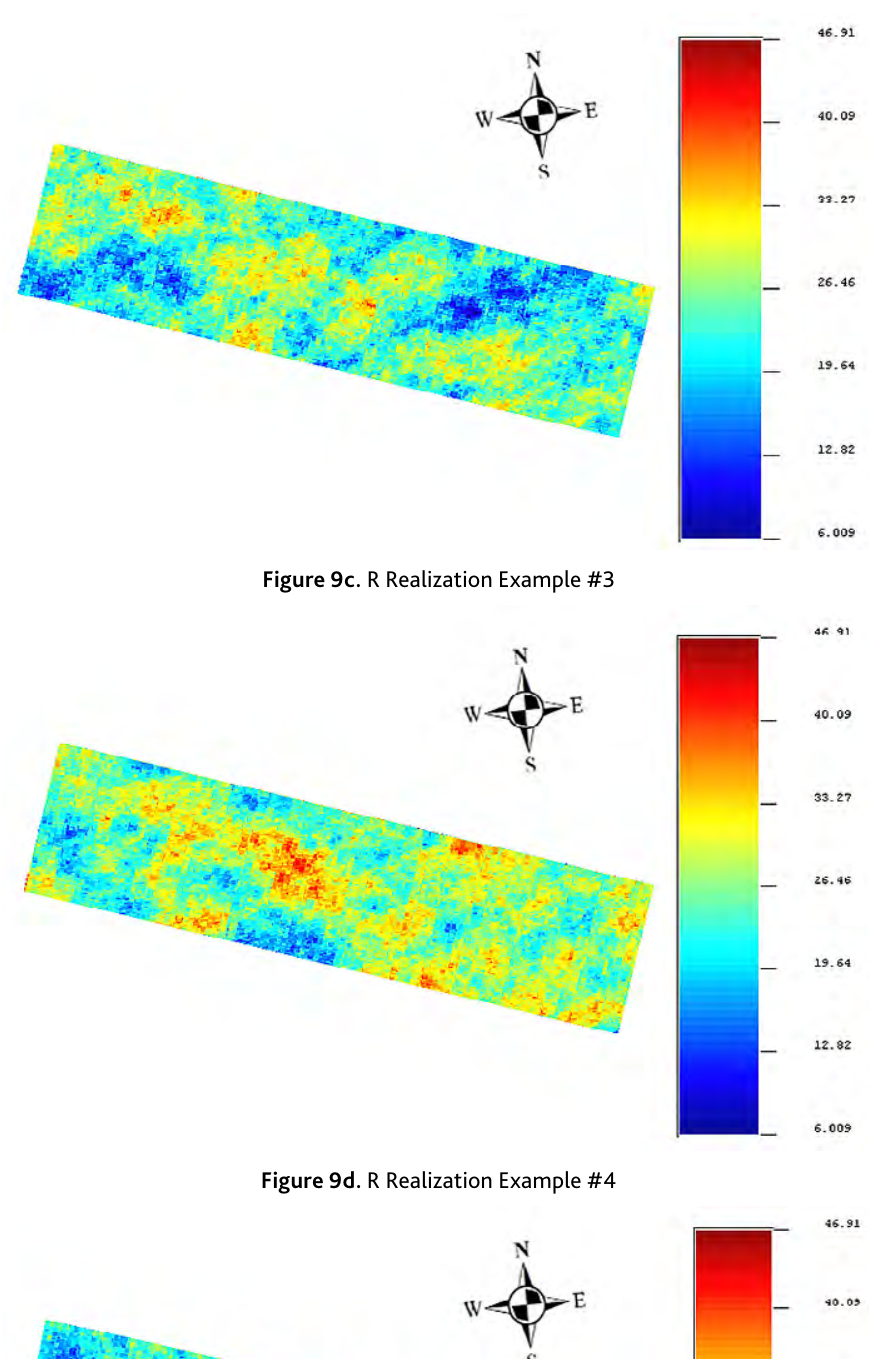
Figure 9d. R Realization Example